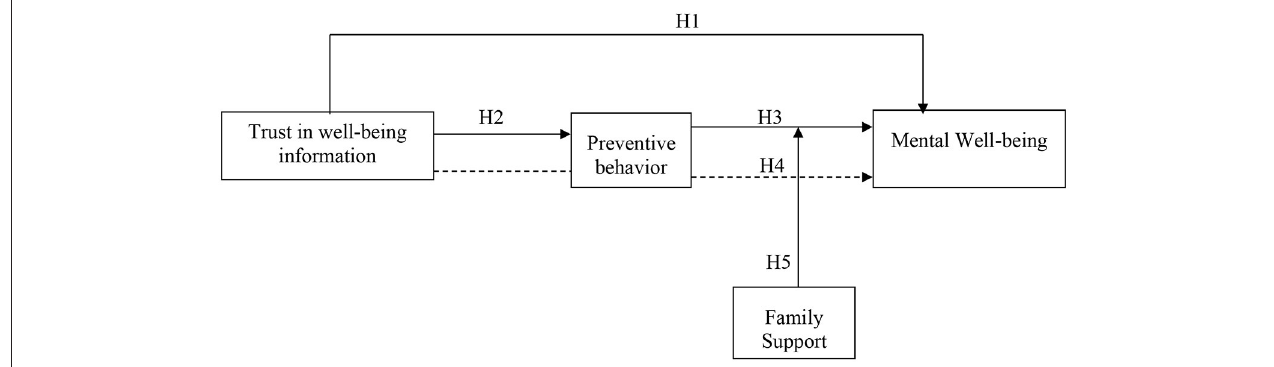
FIGURE 1 | Theoretical